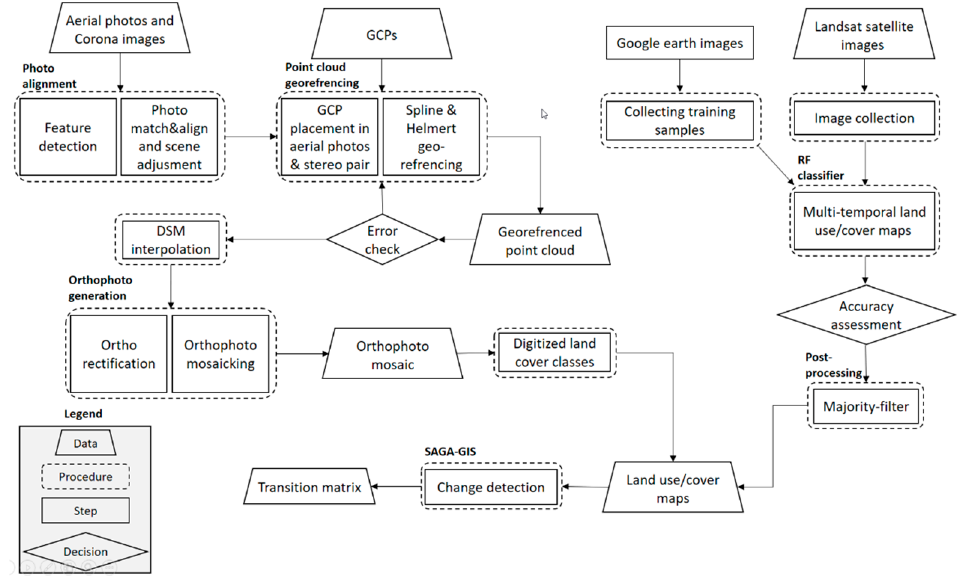
Figure 4. Flowchart of the data and procedures used for LCLUC detection .